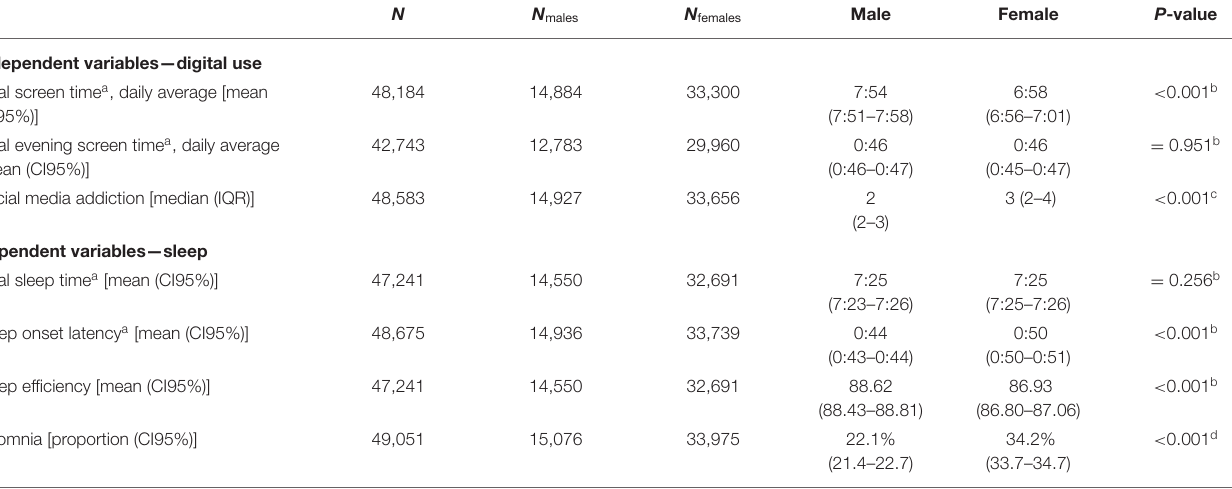
TABLE 1 | Description of study variables across gender. N N males N females Male Female P -value